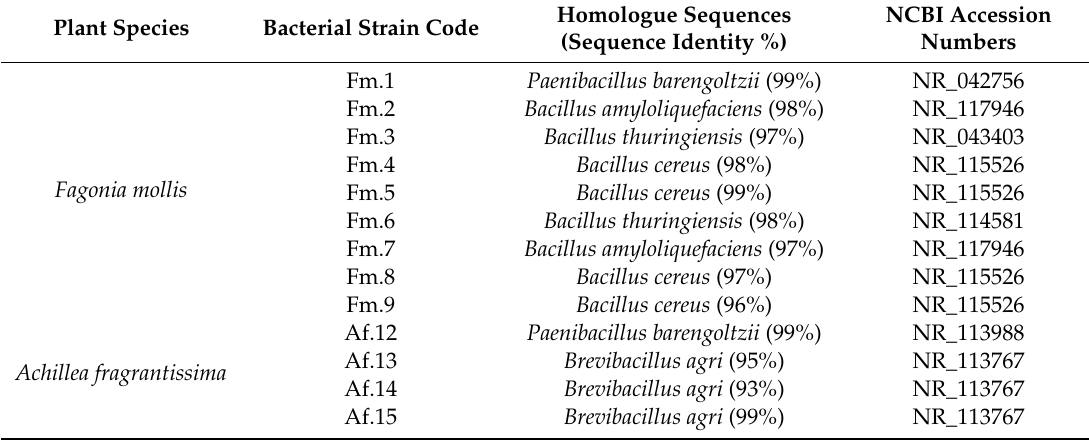
Table 2. The 16S rRNA sequence identification of endophytic bacterial strains from two di ff erent medicinal